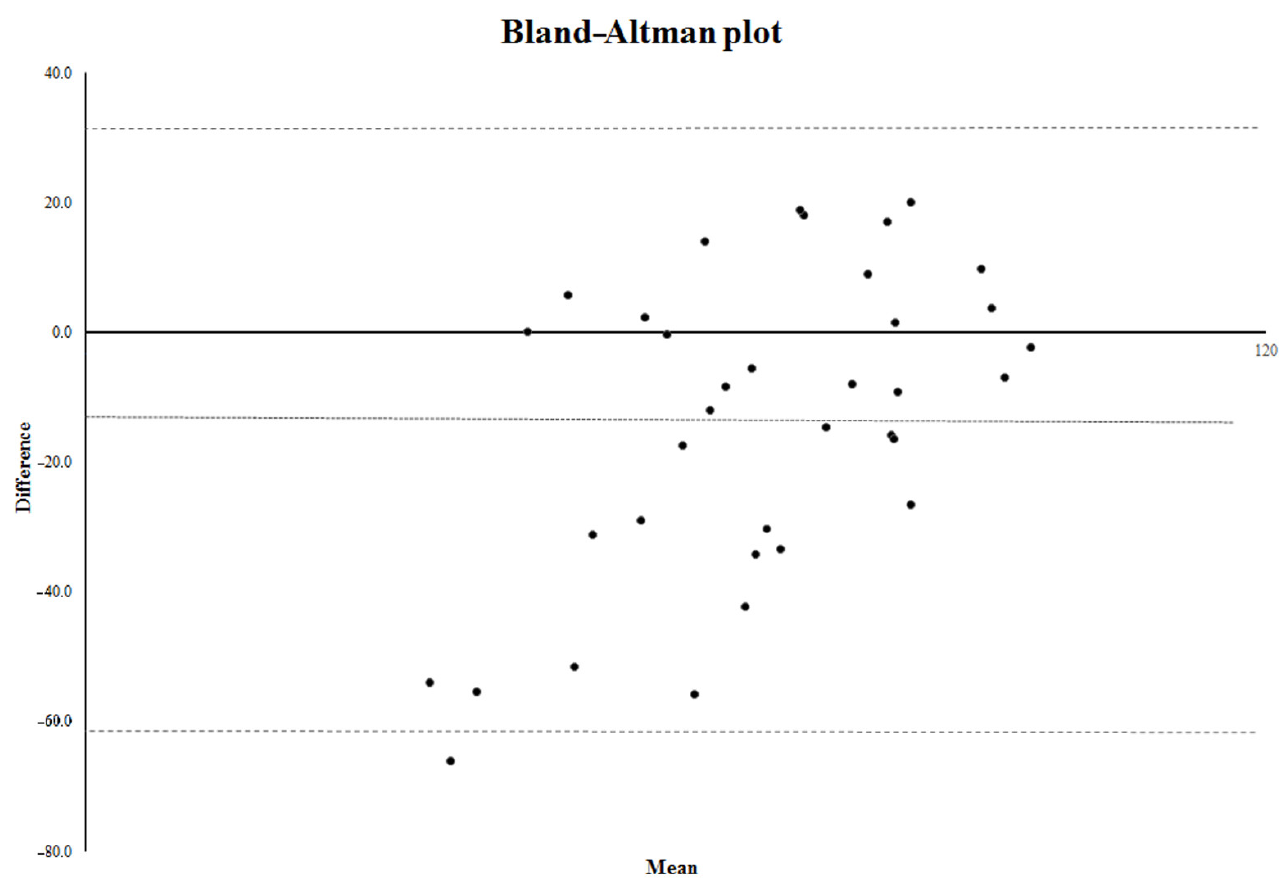
Figure 2. Bland–Altman analysis of agreement of the Richards-Campbell Sleep Questionnaire and the Sleep Efficiency Index measured by polysomnography. The dotted lines represent the upper and the lower limits of agreement. The spotted line represents the mean difference between the RCSQ and the PSG.